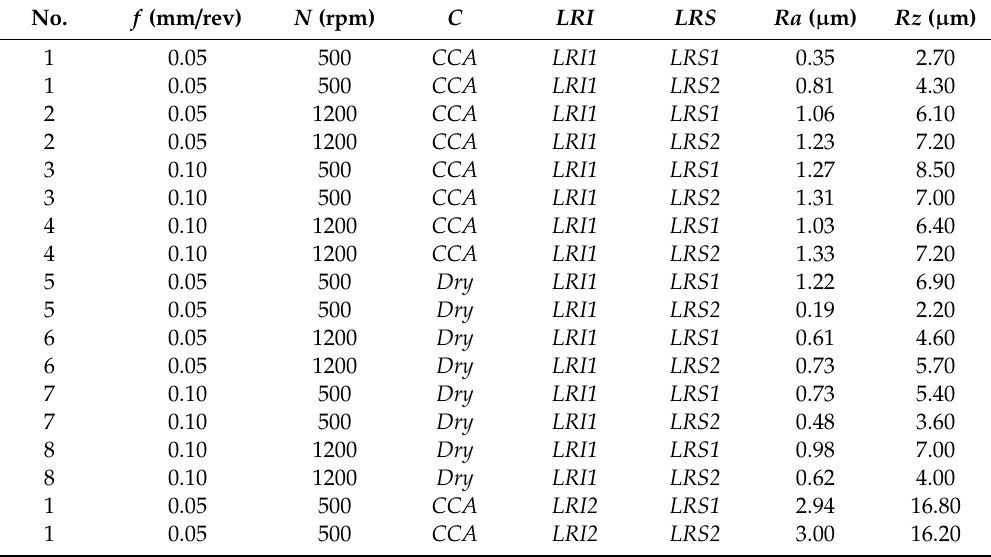
Table 5. The arithmetical mean roughness ( Ra ) and the average maximum height ( Rz ) obtained during the measurement tests .